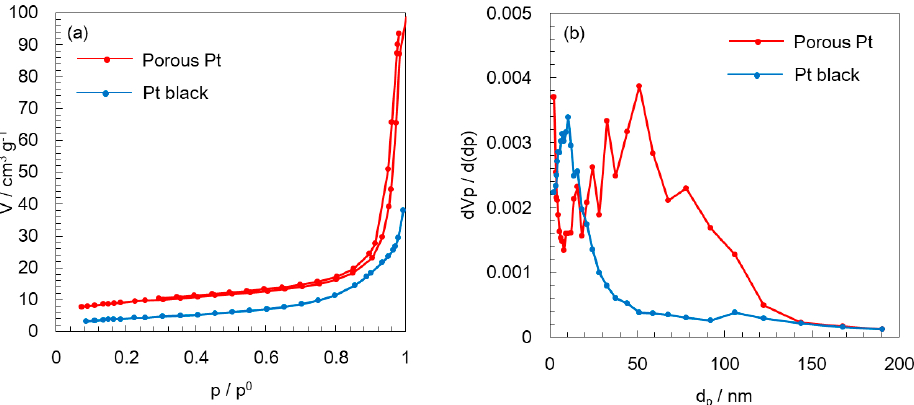
Figure 1. ( a ) Nitrogen adsorption/desorption isotherms and ( b ) corresponding pore distributions of porous Pt and Pt black.